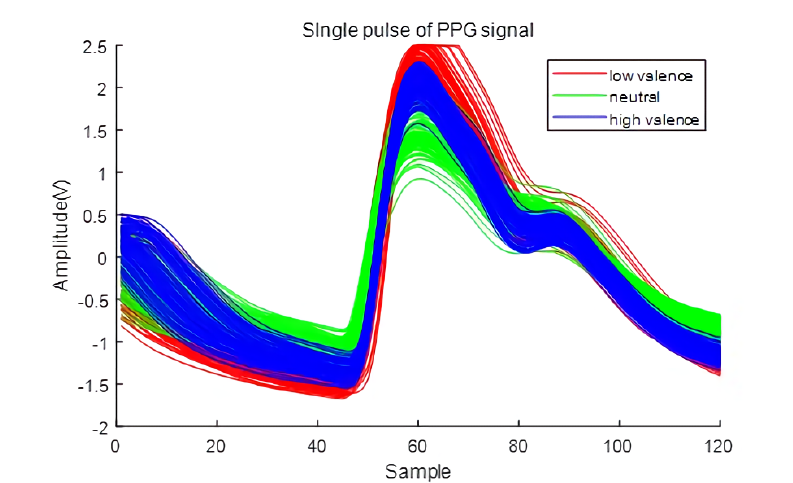
Figure 4. Dividing PPG signals into a single